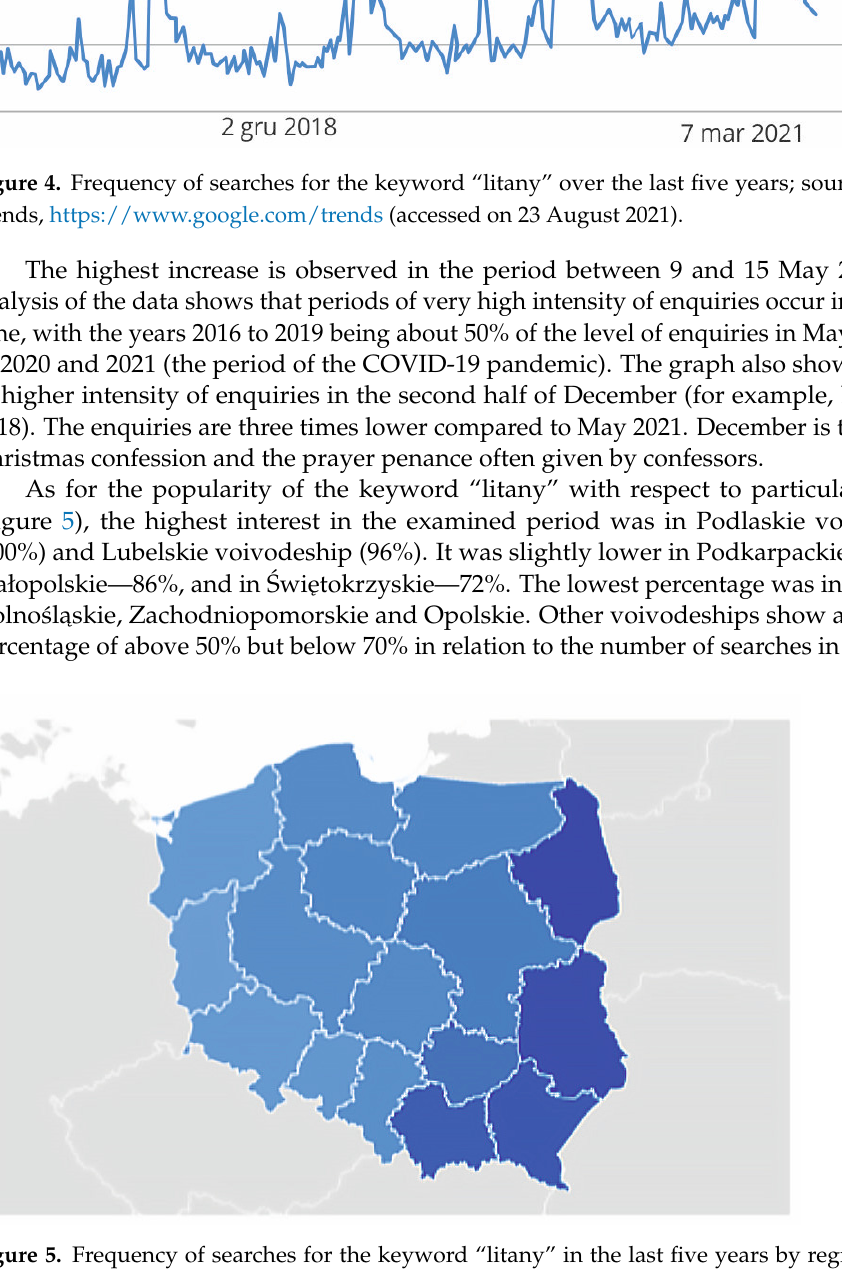
Figure 6. Frequency of searches for the keyword “Litany of Loreto” over the last five years; source: Google Trends, https://www.google.com/trends (accessed on 10 July 2021). The data in the graph show a clear increase in the interest in the keyword in May each year. However, the average frequency of queries in May each year is not the same. There are five periods considered, that is, May from 2016 to 2021 is treated as a separate population. The average number of queries in the respective sub-periods are: 63.22, 59.77, 65.39, 78.8, and 73.1. Analysis of the data indicates that the average frequency in 2020 and 2021 (the pan- demic period) is higher than in 2016–2019. Due to the lack of daily data, Student’s t -test cannot be directly applied. Nevertheless, the application of Student’s t -test to the averaged data confirms the above thesis. Using Google Trends, a change can be observed between May and June (2021) re- garding the search for the Litany of Loreto and the Litany of the Sacred Heart of Jesus (Figure 7). In Poland, Catholics tend to be more attached to the Litany of Loreto than to the Litany of the Sacred Heart of Jesus.